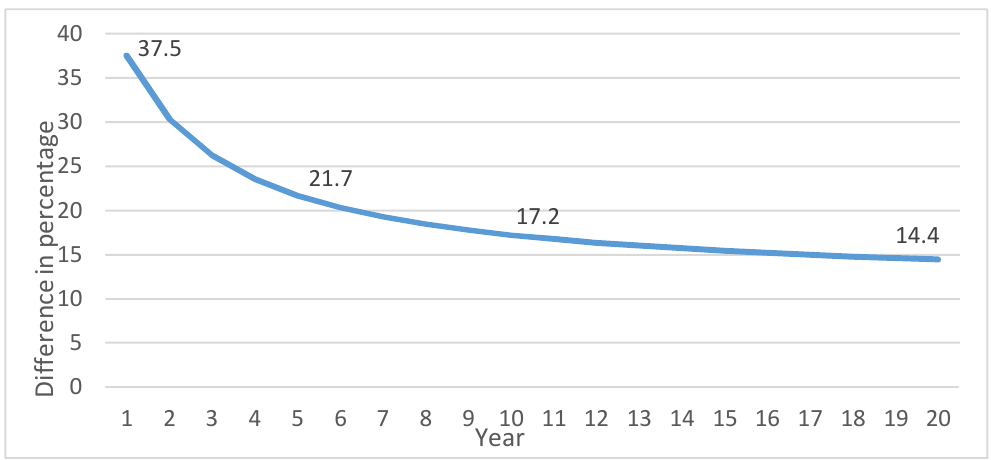
Figure 6. Accumulative total cost comparison in 1000 USD during 20 years for split lateral and CHL.